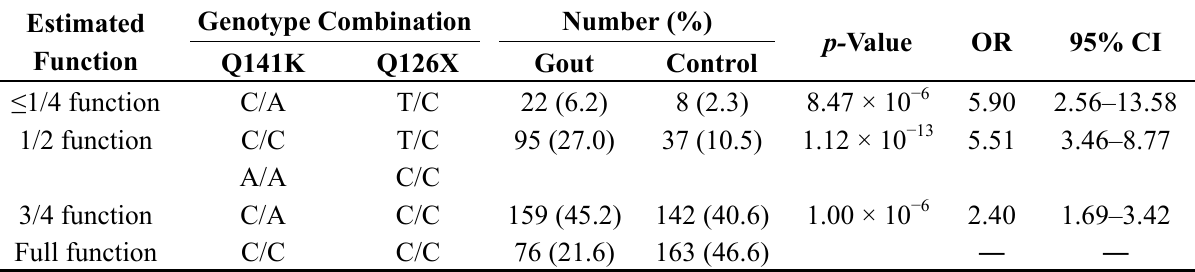
Table 3. Participants’ ABCG2 function